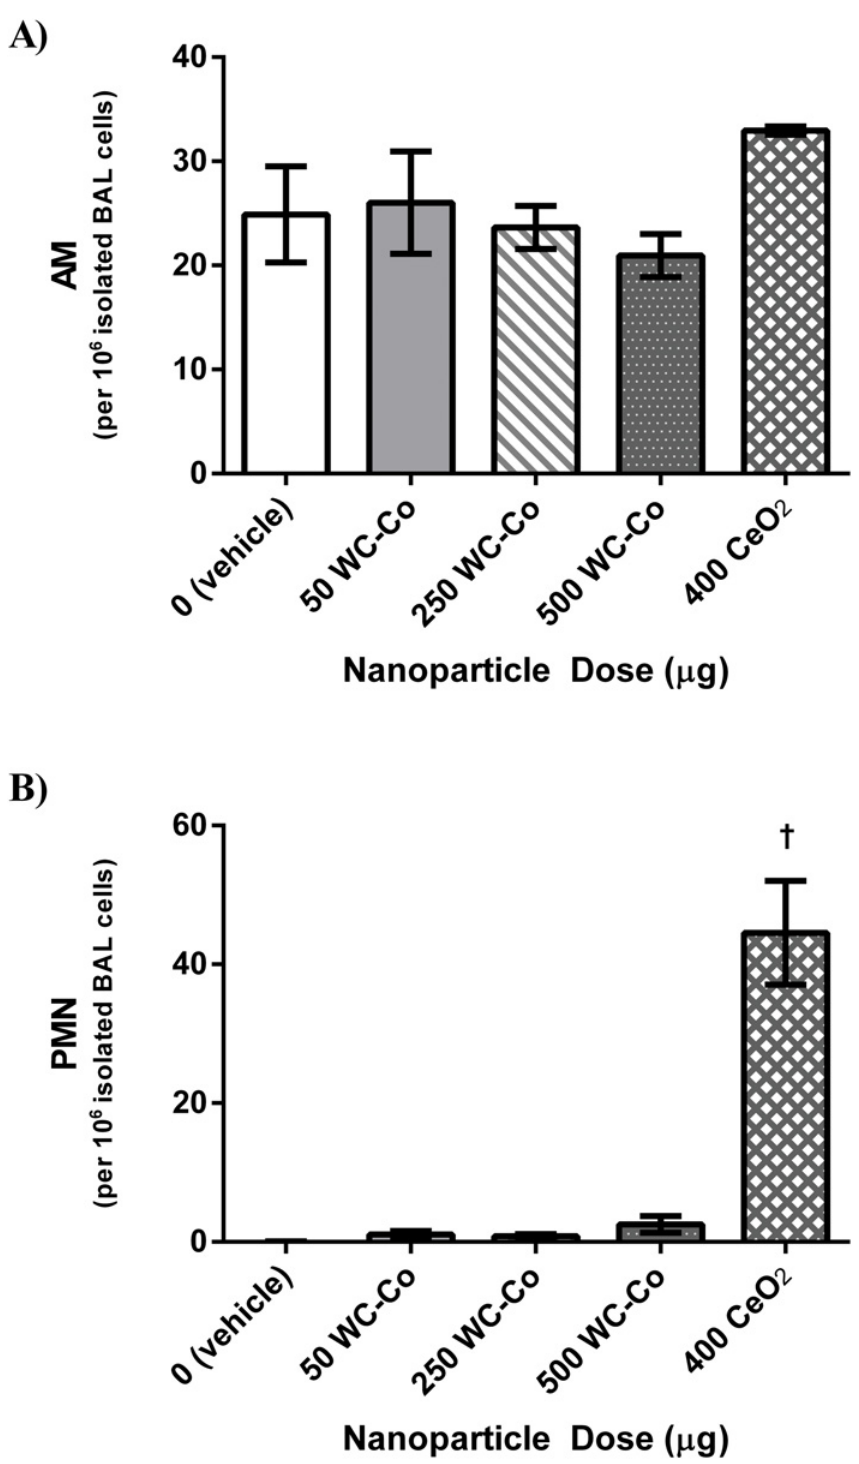
Fig 3. Inflammatory cells quantified in BAL fluid samples following 24-hr exposure to WC-Co and CeO 2 NPs: A) alveolar macrophages (AM) and B) polymorphonuclear leukocytes (PMN), represented as the total number of AM/PMN per 10 6 isolated BAL cells per rat. Values presented as mean ± SD. ( † P < 0.01 compared to the vehicle control and WC-Co NP exposed